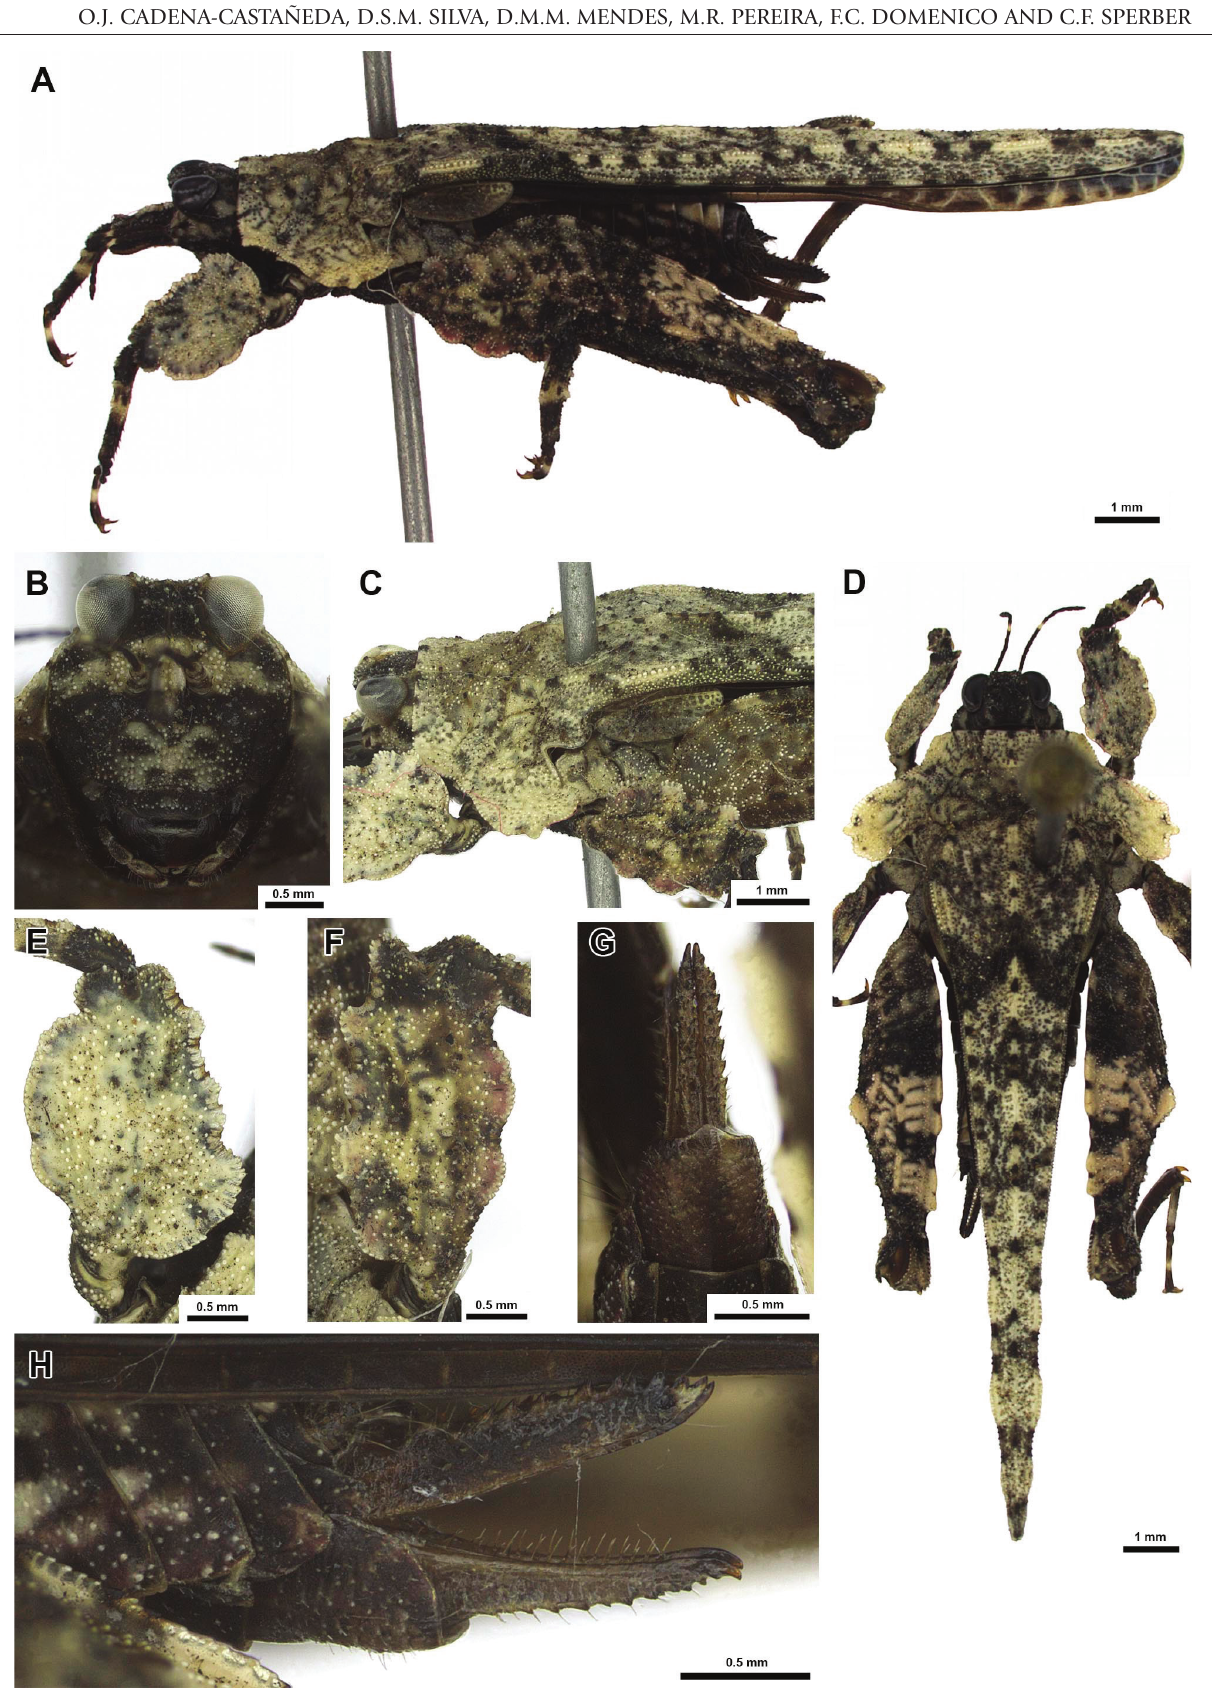
Fig. 1. Amorphopus notabilis (female). A. Habitus in lateral view; B. Frons; C. Head, lateral lobes of pronotum and tegmina in lateral view; D. Habitus in dorsal view; E. Fore-femur; F. Mid-femur; G. Terminalia in ventral view; and H. In lateral